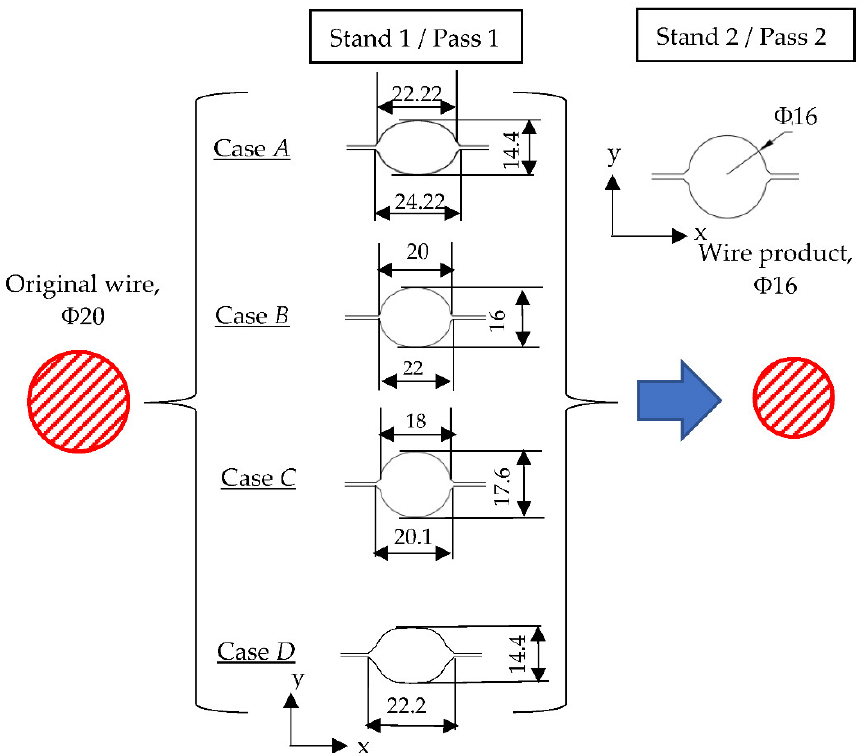
Figure 1. Roller groove-shape designs for round-oval-round (case A, B, C) and round-Bézier-round (case D).